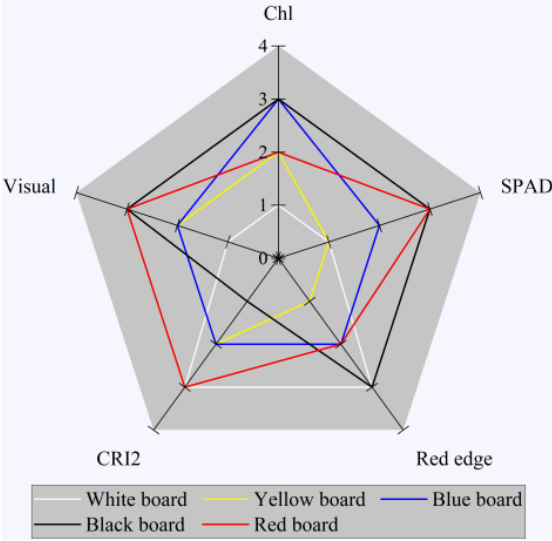
Figure 19. Relative health radar chart of five verified PeITCs.